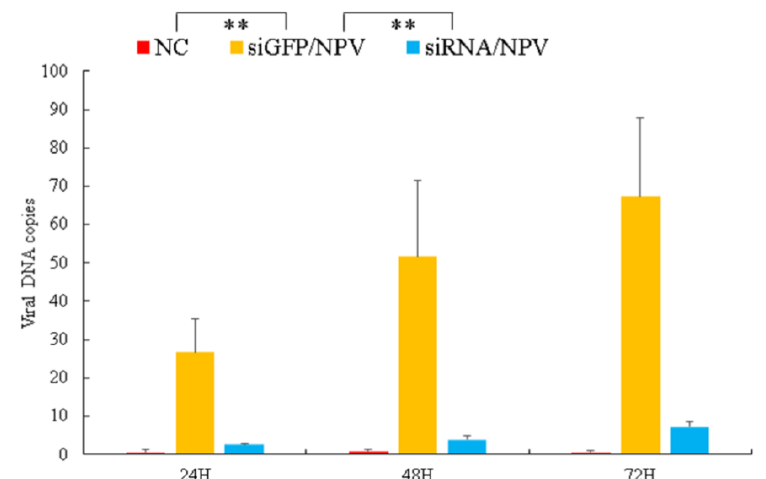
Figure 10. Viral genomic copies in Bmserpin2- depleted haemolymph. The BmNPV viral DNAs were extracted from haemolymph, and qPCR was performed to determine viral genomic DNA copies. Haemolymph from negative control (NC), GFP infected with BmNPV (siGFP/NPV) and Bmserpin2 siRNA infected with BmNPV (siRNA/NPV) were collected at 24, 48 and 72 h after BmNPV infection. Data were shown as mean ± SD ( n = 3). Statistical analysis was performed using SPSS software. Significant differences are indicated by * ( p < 0.05) or ** ( p < 0.01).